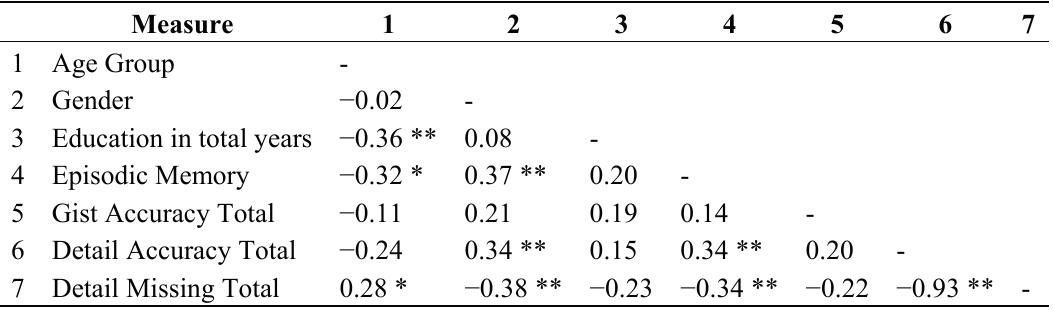
Table 2. Correlations between person characteristics, education, episodic memory and recall